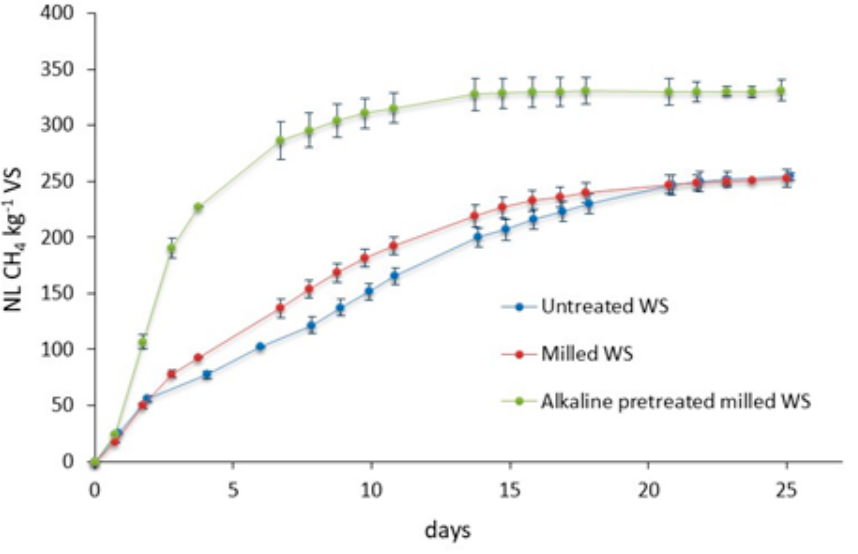
Figure 3. Cumulative methane production (NL CH 4 kg − 1 VS) during BMP tests of untreated WS, milled WS, and alkaline-pretreated milled WS.